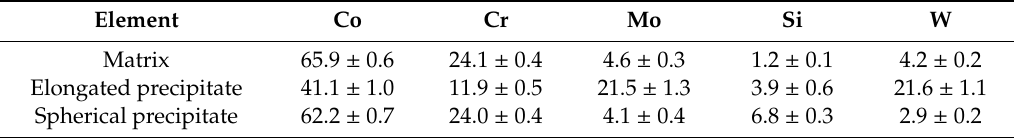
Table 2. Experimental results (wt.%) of STEM-EDS analysis at the points indicated in Figure 4a.